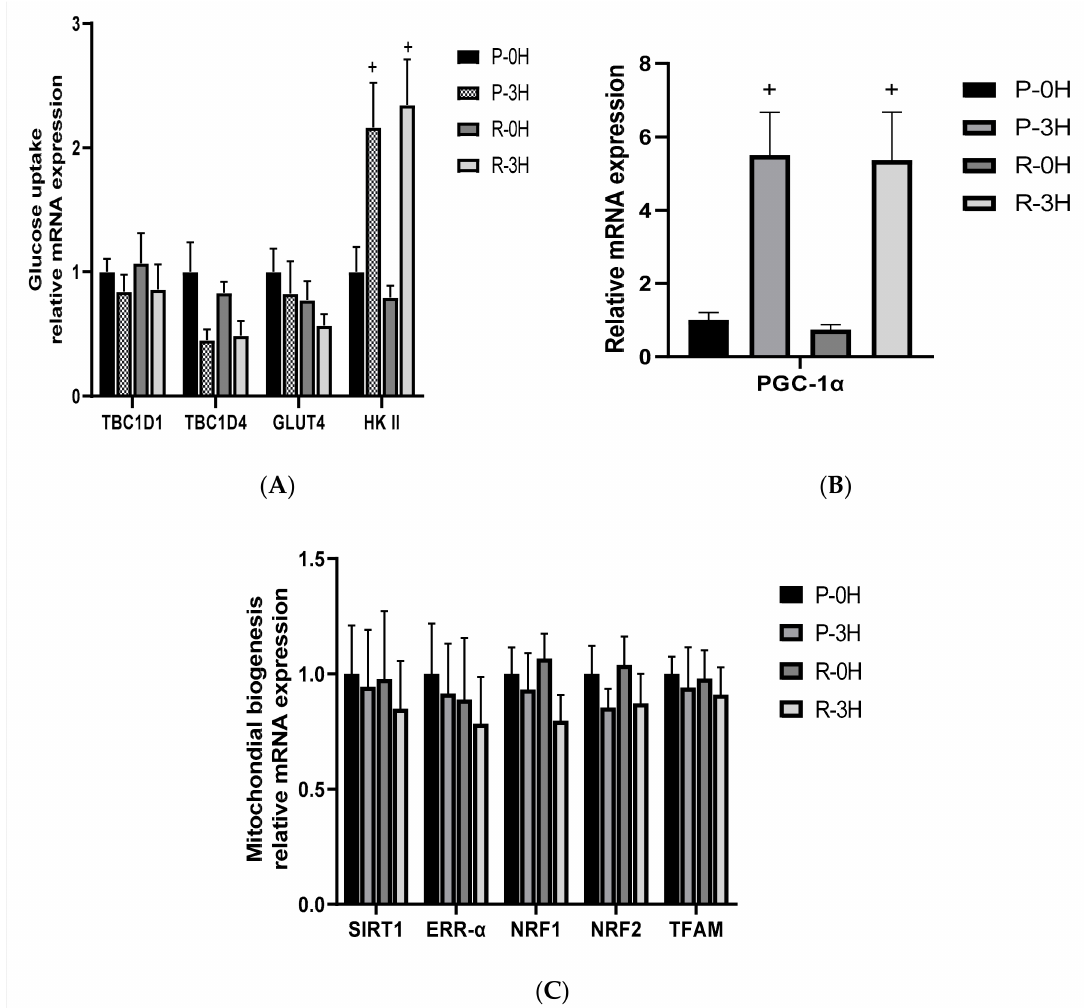
Figure 3. Insulin stimulates glucose uptake related gene expression ( A ), PGC-1 α ( B ) and mitochondrial biogenesis-related gene expression ( C ) in vastus lateralis of human skeletal muscle after a single bout of exercise in RES and placebo trials. P-0H: immediately after exercise in placebo trial; P-3H: 3 h after exercise in placebo trial; R-0H: immediately after exercise in resveratrol trial; R-3H: 3 h after exercise in resveratrol trial. Values are expressed as mean ± SE, N = 9. + Significant di ff erence against 0 h (immediately after exercise; p <